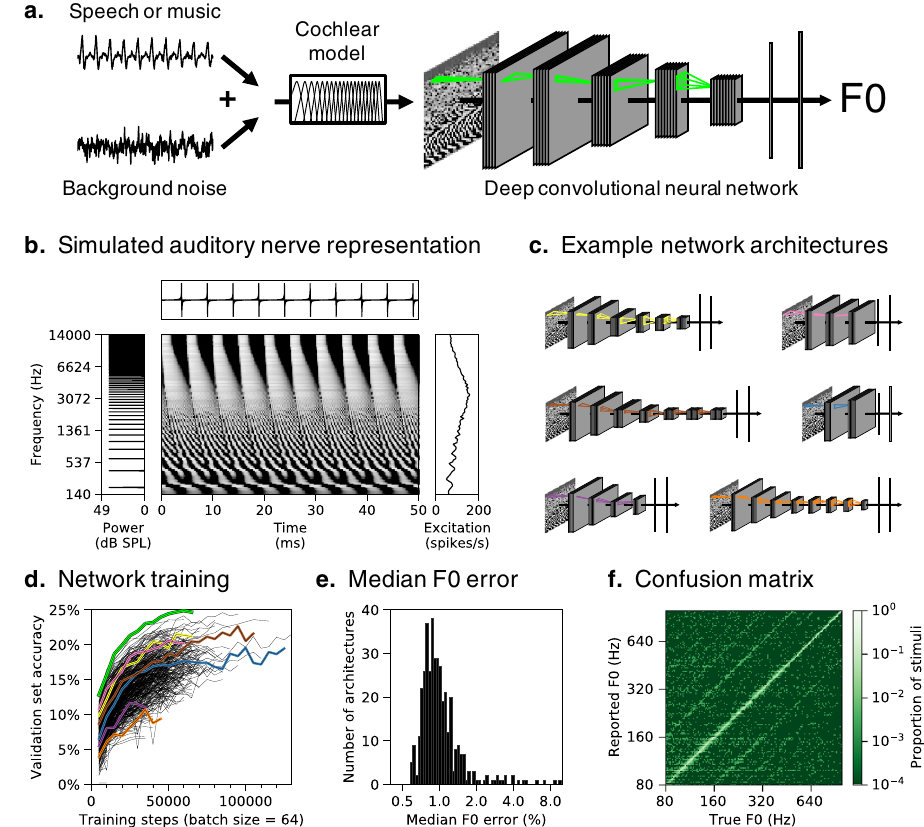
Fig. 1 Pitch model overview. a Schematic of model structure. DNNs were trained to estimate the F0 of speech and music sounds embedded in real-world background noise. Networks received simulated auditory nerve representations of acoustic stimuli as input. Green outlines depict the extent of example convolutional fi lter kernels in time and frequency (horizontal and vertical dimensions, respectively). b Simulated auditory nerve representation of a harmonic tone with a fundamental frequency (F0) of 200 Hz. The sound waveform is shown above and its power spectrum is shown to the left. The waveform is periodic in time, with a period of 5ms. The spectrum is harmonic (i.e., containing multiples of the fundamental frequency). Network inputs were arrays of instantaneous auditory nerve fi ring rates (depicted in greyscale, with lighter hues indicating higher fi ring rates). Each row plots the fi ring rate of a frequency-tuned auditory nerve fi ber, arranged in order of their place along the cochlea (with low frequencies at the bottom). Individual fi bers phase- lock to low-numbered harmonics in the stimulus (lower portion of the nerve representation) or to the combination of high-numbered harmonics (upper portion). Time-averaged responses on the right show the pattern of nerve fi ber excitation across the cochlear frequency axis (the “ excitation pattern ” ). Low-numbered harmonics produce distinct peaks in the excitation pattern. c Schematics of six example DNN architectures trained to estimate F0. Network architectures varied in the number of layers, the number of units per layer, the extent of pooling between layers, and the size and shape of convolutional fi lter kernels d Summary of network architecture search. F0 classi fi cation performance on the validation set (noisy speech and instrument stimuli not seen during training) is shown as a function of training steps for all 400 networks trained. The highlighted curves correspond to the architectures depicted in a and c . The relatively low overall accuracy re fl ects the fi ne-grained F0 bins we used. e Histogram of accuracy, expressed as the median F0 error on the validation set, for all trained networks (F0 error in percent is more interpretable than the classi fi cation accuracy, the absolute value of which is dependent on the width of the F0 bins). f Confusion matrix for the best-performing network (depicted in a ) tested on the validation